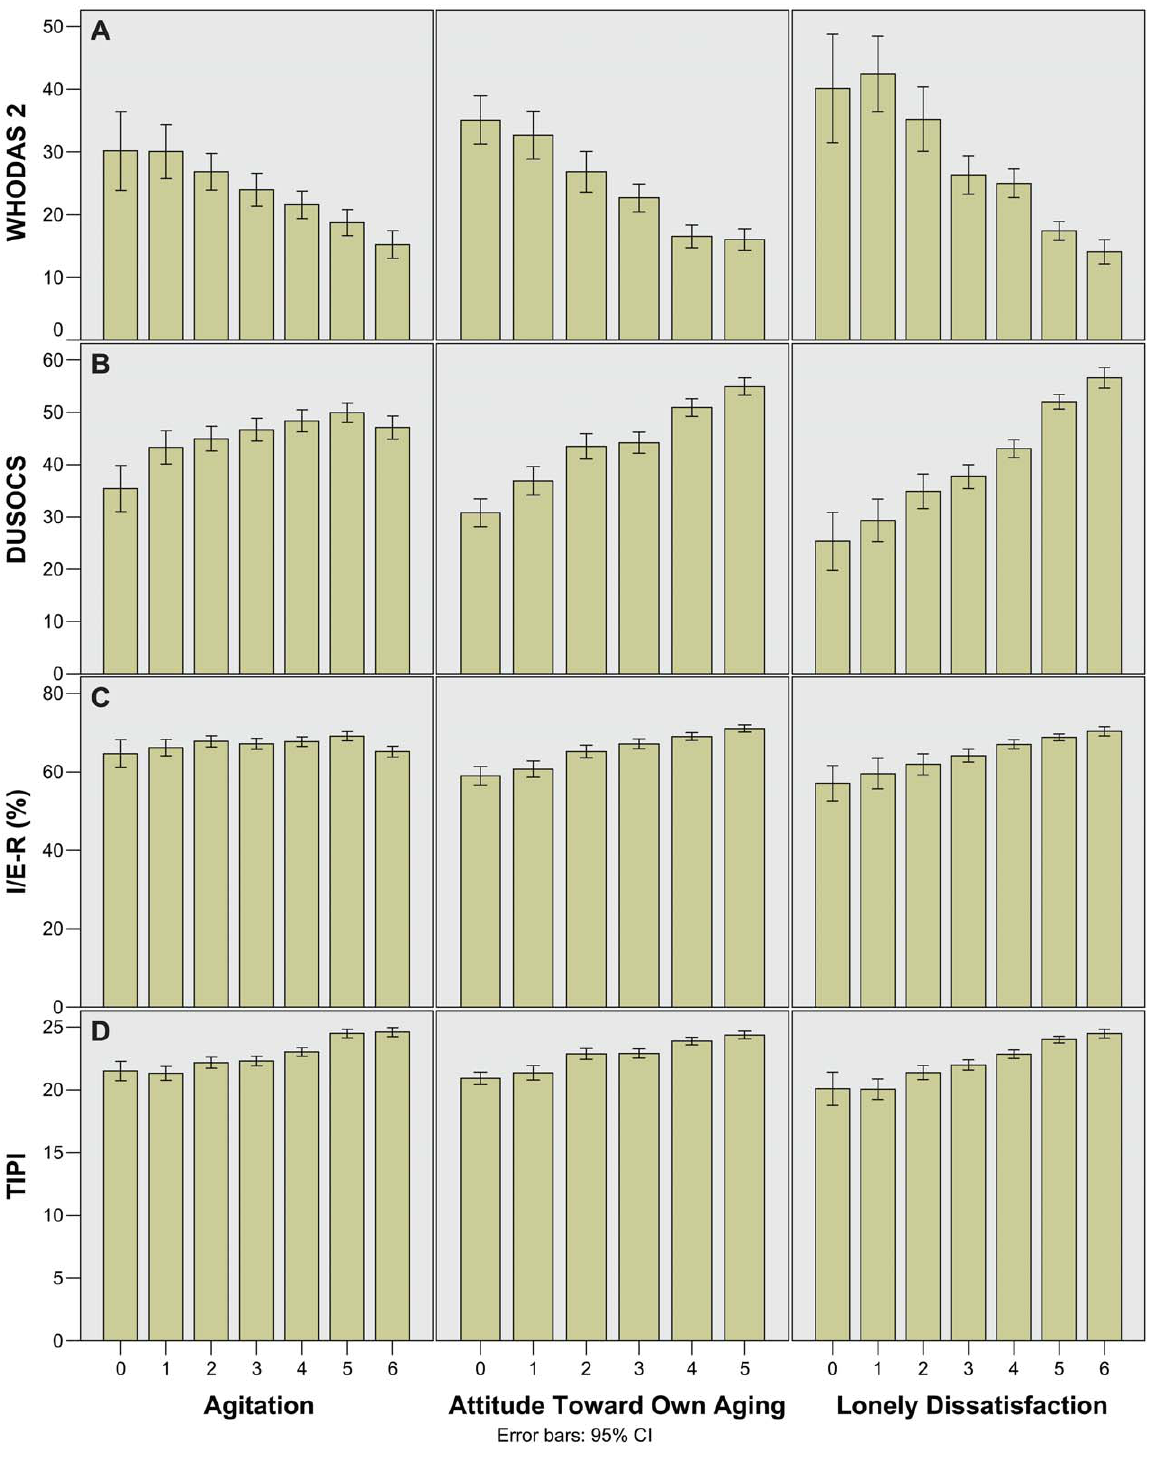
Figure 6. Bar charts showing WHODAS-II, DUSOCS, I/E-R, and TIPI against PGC morale domains. A) WHODAS-II, B) DUSOCS, C) I/E-R, and D) TIPI mean scores.